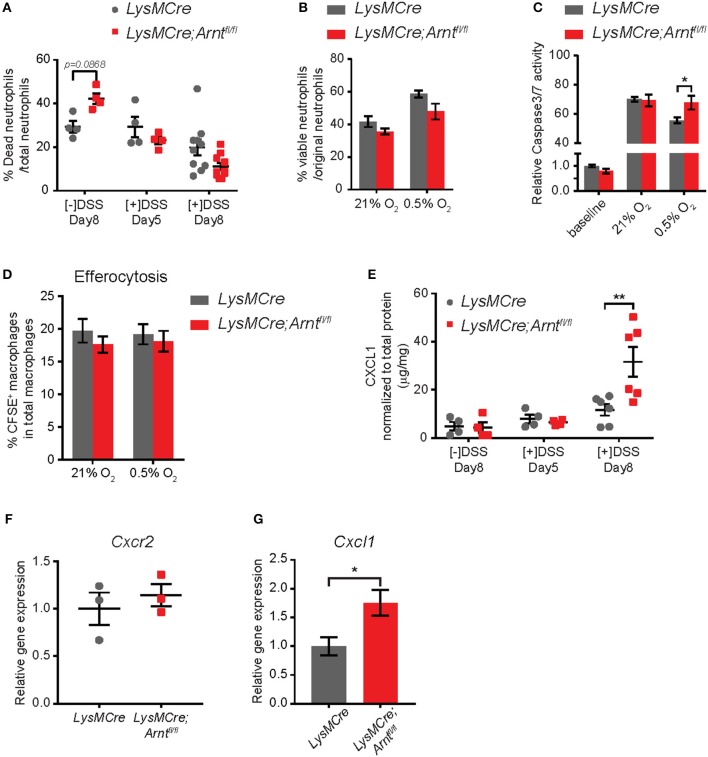
Increased neutrophil numbers in lamina propria of LysMCre;Arntfl/fl mice is due to elevated CXCL1, not enhanced survival. (A) Percentage of dead neutrophils normalized to total neutrophil numbers in lamina propria. Data represent untreated mice ([–]DSS) sacrificed on day 8 (n = 4) and DSS-treated mice ([+]DSS) sacrificed on day 5 (n = 4) and day 8 (n = 10). (B) Viability of bone marrow-derived neutrophils (BMDNs) from LysMCre (n = 3) and LysMCre;Arntfl/fl (n = 3) mice cultured under normoxia or hypoxia for 24 h. Viability was determined by Trypan Blue exclusion. (C) Caspase3/7 activity assay performed with BMDNs from LysMCre (n = 3) and LysMCre;Arntfl/fl (n = 3) mice. Baseline measurement was conducted using BMDNs immediately after isolation from bone marrow. (D) Efferocytosis of apoptotic neutrophils by LysMCre (n = 3) and LysMCre;Arntfl/fl (n = 3) BMDMs under normoxia and hypoxia overnight (14 h). CFSE+ macrophages represent macrophages that engulfed CFSE-labeled apoptotic neutrophils. (E) ELISA analysis of CXCL1 in colonic explant supernatants. (F) RT-qPCR analysis of Cxcr2 expression in LysMCre and LysMCre;Arntfl/fl BMDNs. (G) RT-qPCR analysis of Cxcl1 expression in sorted lamina propria macrophages from LysMCre and LysMCre;Arntfl/fl mice. Data presented as mean ± s.e.m. Two-way ANOVA for (A–E) and Student's t-test for (F,G); *p < 0.05 and **p < 0.01.